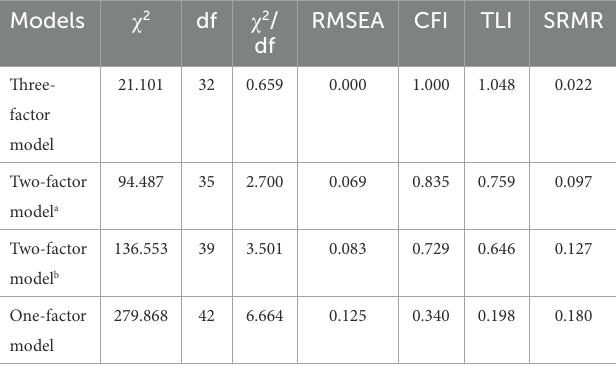
TABLE 3 The results of confirmatory factor analyses for measurement model.